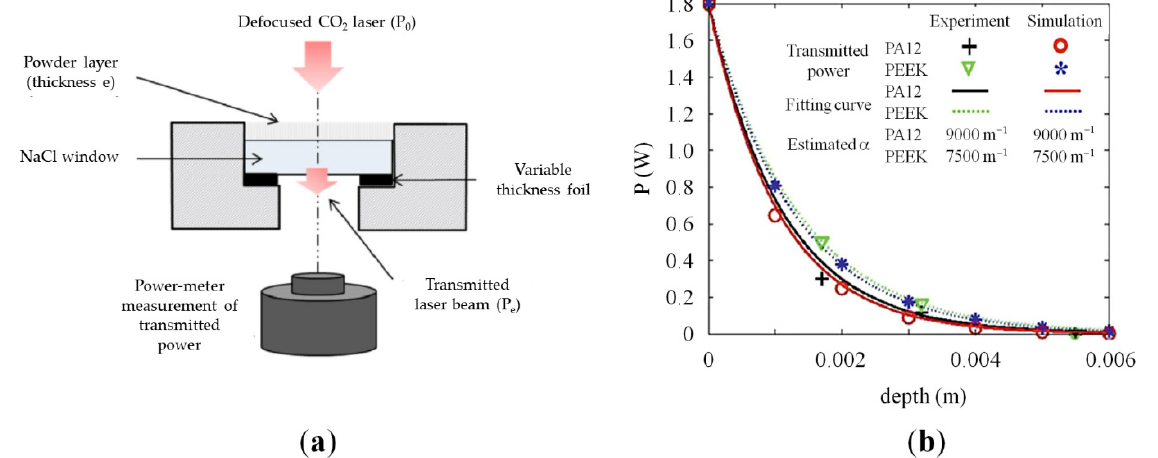
Figure 8. ( a ) Scheme of the experimental device used by Peyre [67] to measure the transmitted laser power through a power bed layer with variable thickness; ( b ) comparison between experimental results from Peyre [67] and DEM results from Xin [81] of the laser power transmission within PA12 and PEEK powder bed obtained using an incident power of 1.8 W. The symbols correspond to the measured and simulated values, and the continuous and dashed lines correspond to the Beer–Lambert law fitting that allowed the evaluation of the attenuation coefficient. Reproduced with permission from [67,81].